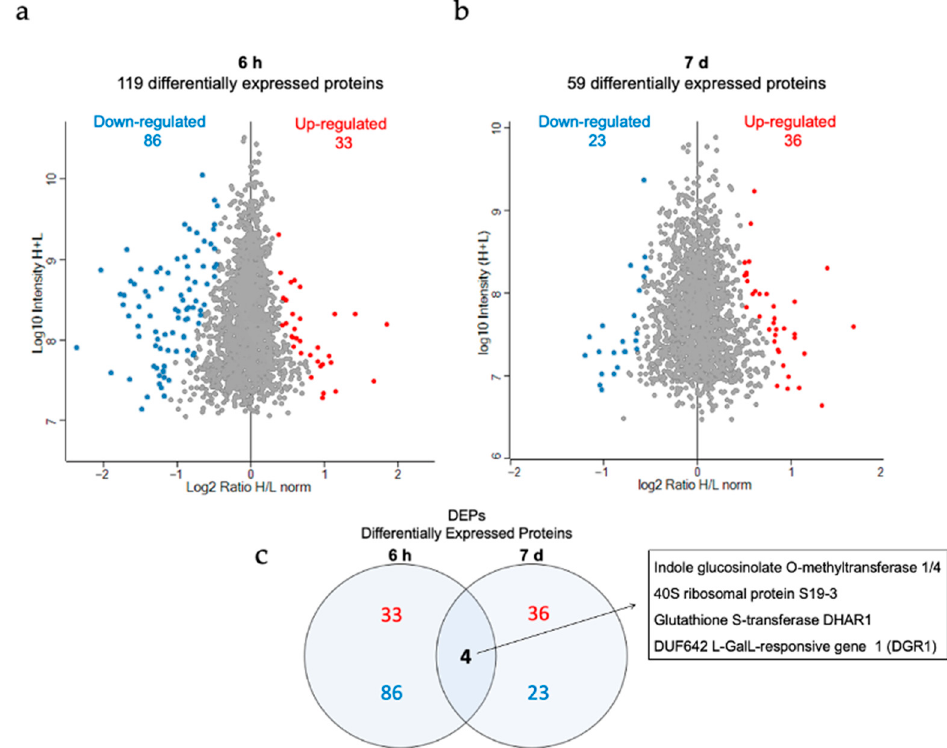
Figure 6. DEPs after AuNP-SCTA treatment. Volcano plots representing DEPs (upregulated proteins: red dots; downregulated proteins: blue dots) and non-DEPs (grey dots) in Arabidopsis seedlings after ( a ) short- and ( b ) long-term AuNP-SCTA treatment (6 h and 7 d, respectively) and detected by nano-liquid chromatography with tandem mass spectrometry (NanoLC-MS/MS) of total protein extracts. The X-axis represents the log 2 transformed fold changes; the Y-axis represents the log 10 transformed intensity (in log10), with H representing the treatment and L the control. ( c ) Venn diagram displaying the total number of up- (red) and downregulated (blue) differentially expressed proteins in both treatments and the protein names of the 4 overlapping proteins.